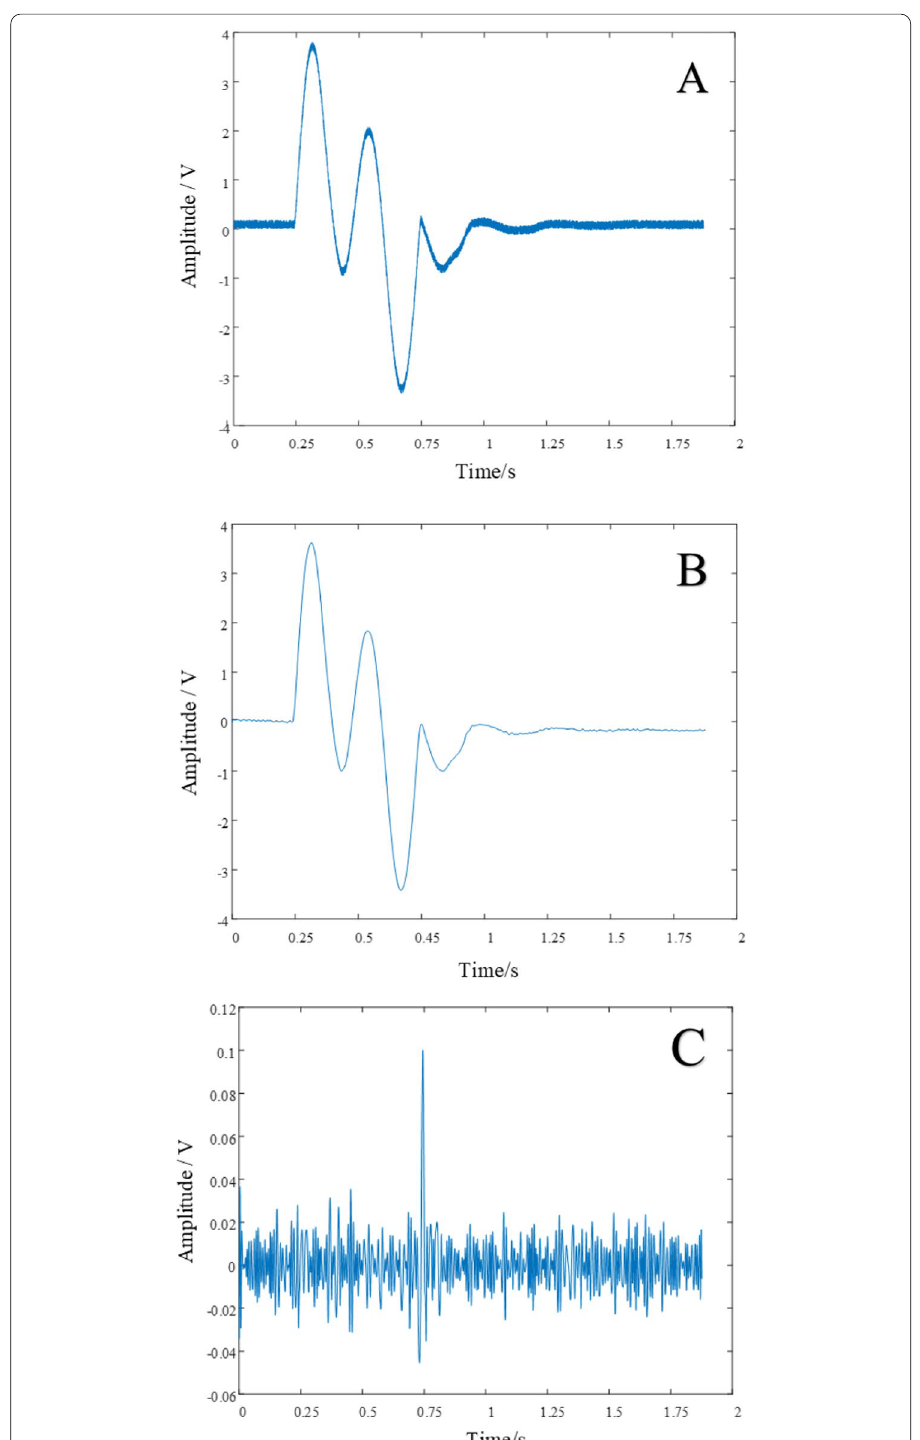
Fig. 15 EMD processing result. A Received signal, B estimated signal by EMD, and C estimated noise by